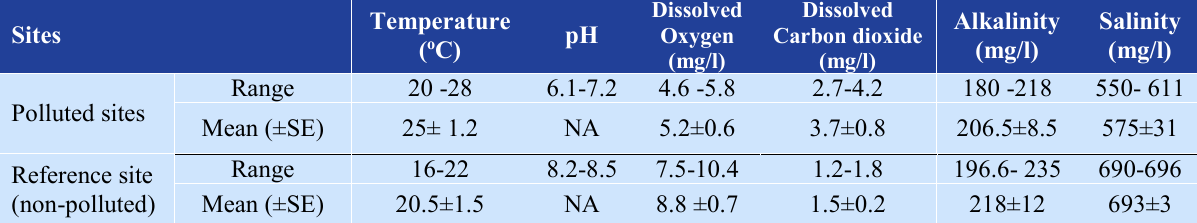
Table 1. Major water quality parameters of aquatic habitats from which fishes were sampled during August, 2013 to November, 2013. Note: Uninfected fishes were collected from Murti river (Jalpaiguri district in West Bengal, India) which served as a non-polluted reference